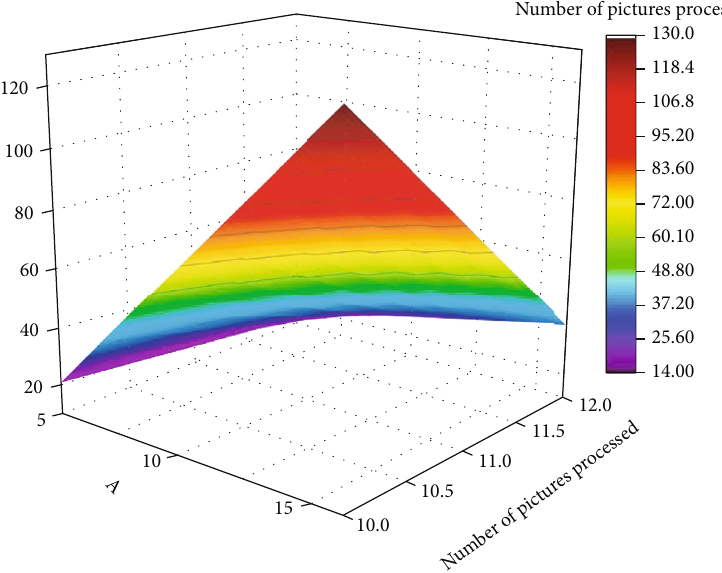
Figure 7: Data plot for increasing dimensionality of feature vectors.